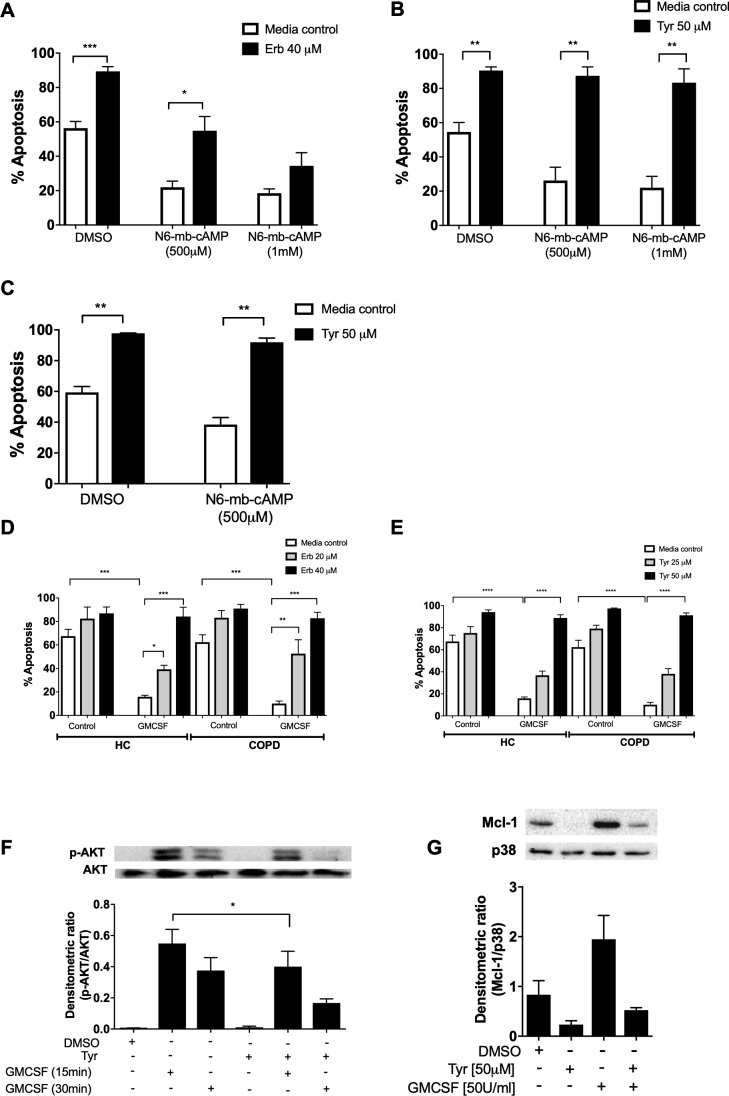
Erbstatin and tyrphostin AG825 overcome pro-survival effects of N6-MB-cAMP and GMCSF.Neutrophils were incubated with DMSO, Erbstatin [Erb, 40 µM] (A) or tyrphostin AG825 [Tyr, 50 µM] (B) in the presence of DMSO or N6-MB-cAMP [500 µM and 1 mM] for 20 hr. Neutrophils isolated from COPD patients were incubated with DMSO or tyrphostin AG825 [50 µM] in the presence of DMSO or N6-MB-cAMP [500 µM] for 20 hr (C). Neutrophils isolated from COPD patients and age-matched healthy control subjects (HC) were incubated with DMSO, erbstatin (D) [20, 40 µM] or tyrphostin AG825 (E) [25, 50 µM] in the presence or absence of GMCSF [50 u/mL] for 20 hr. Apoptosis was assessed by light microscopy. The data are expressed as mean percentage apoptosis ± SEM from 4 to 6 independent experiments. (F) Neutrophils were incubated with DMSO or tyrphostin AG825 [Tyr, 50 µM] for 60 min before the addition of GMCSF [50 u/mL] for 15 or 30 mins. (G) Neutrophils were incubated with DMSO, tyrphostin AG825 [50 µM] for 60 min before the addition of GMCSF [50 u/mL] for a further 7 hr. Cells were lysed, subjected to SDS-PAGE electrophoresis and membranes probed for p-AKT, Mcl-1 or loading controls, AKT and P38. Images are representative of 3 independent experiments. Charts show densitometric values of 3 individual immunoblots and are expressed as a ratio of target (p-AKT or Mcl-1) over loading control (AKT or P38, respectively). Statistically significant differences were calculated by one-way ANOVA with Sidak post-test (A–C, F–G) or two-way ANOVA with Sidak post-test (D–E) and indicated as *p<0.05, **p<0.01, ***p<0.001.